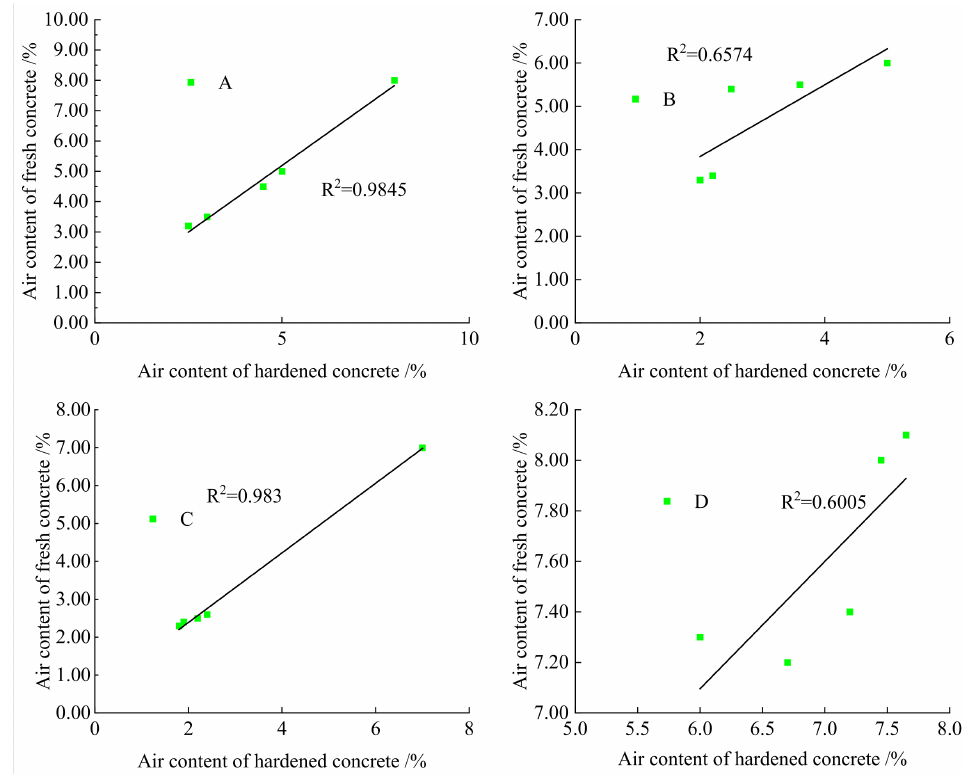
Figure 11. Relationship between the air void of fresh concrete and hardened concrete.